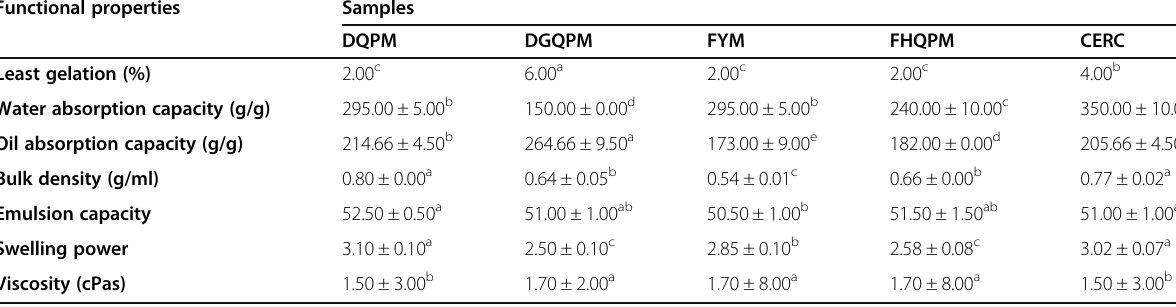
Table 3 Functional properties of blends of maize and almond seed flours Functional